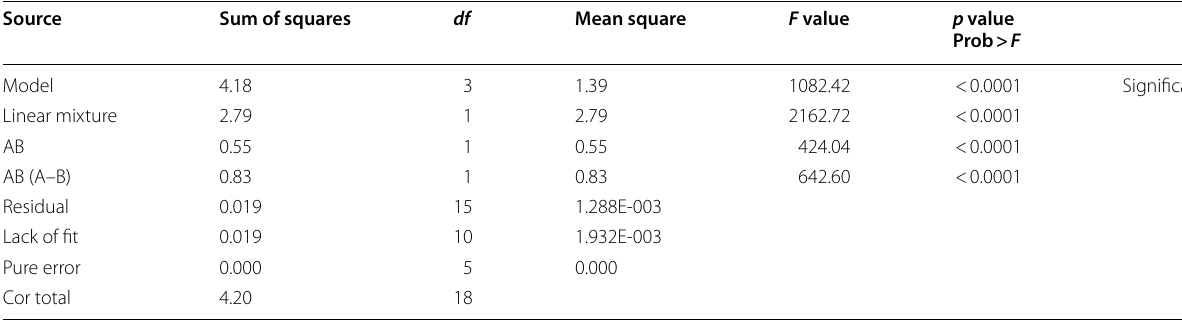
Table 2 Software generated ANOVA table considering retention time of chlorantraniliprole as Response 2 Source